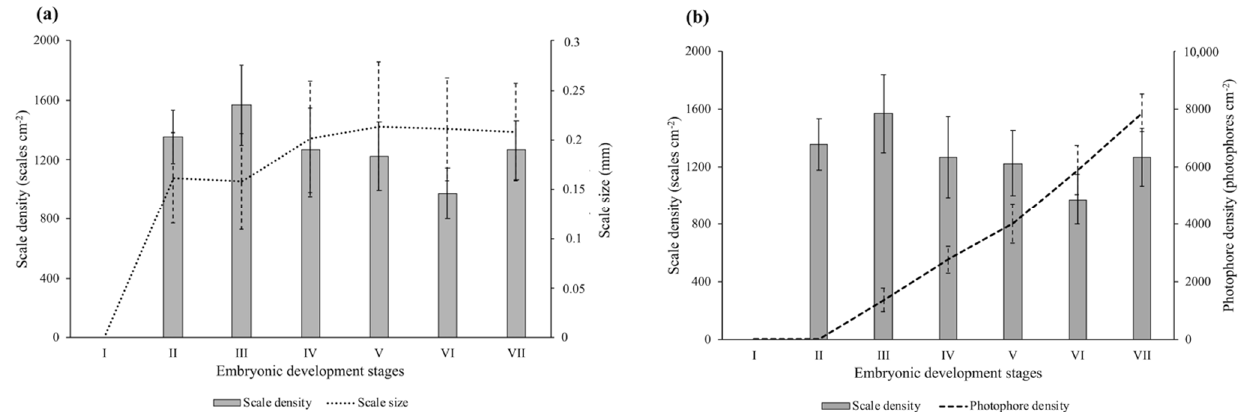
Figure 3. Scales’ and photophores’ parameters across embryogenesis for each analyzed stage. ( a ) Evolution of scales density and scales size. ( b ) Evolution of photophore density and scales density. Data are means ± standard deviation.